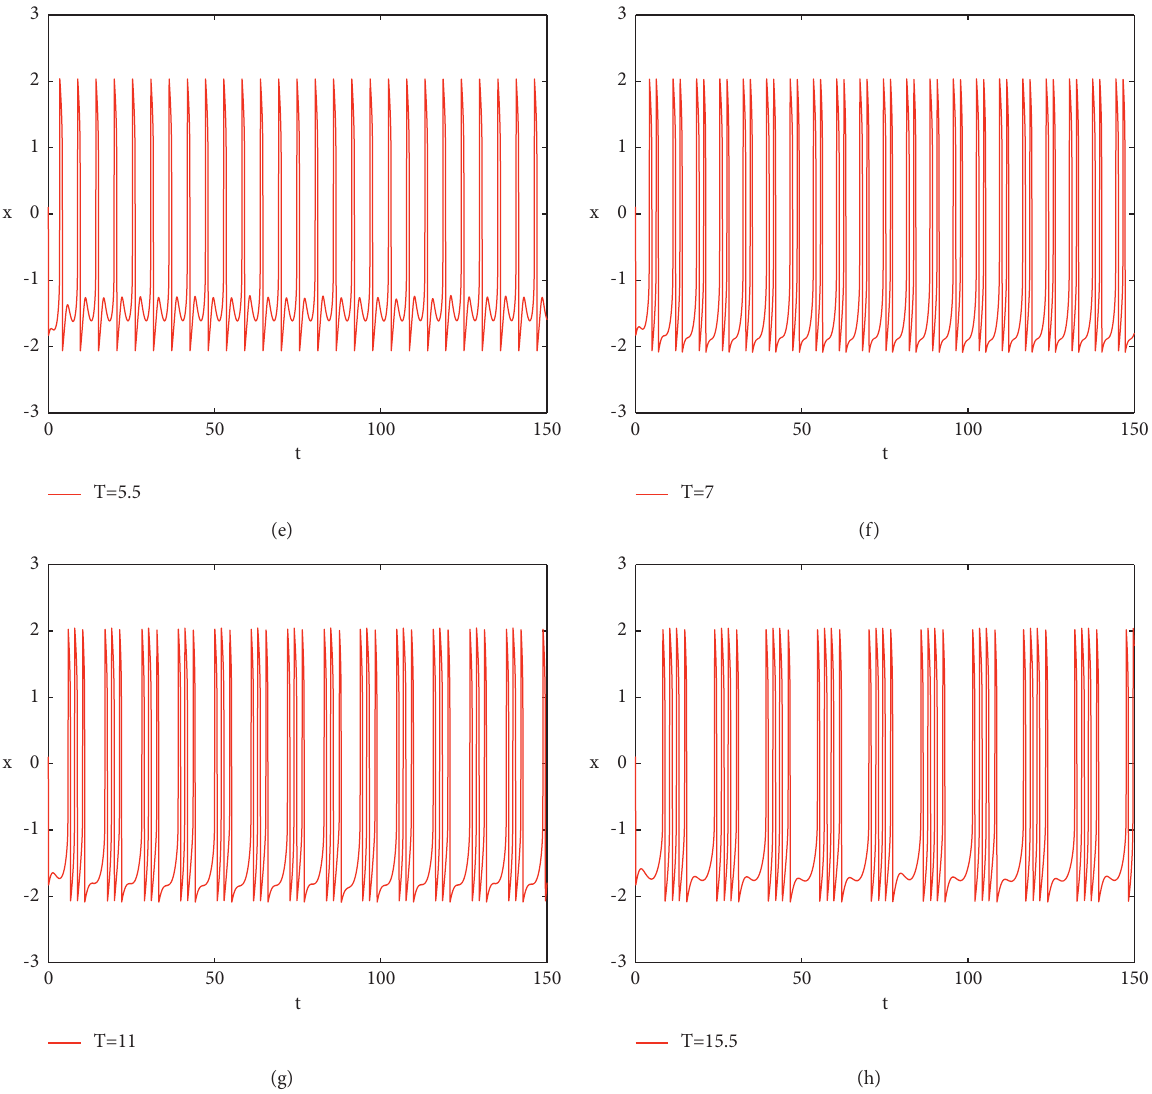
Figure 5: When phase noise amplitude B � 0 . 76, the plot of the coherence resonance coefficient R varying with phase noise period T and the time evolution diagram of the system membrane potential x . (a) Variation of R with T ; (b) T � 2; (c) T � 3; (d) T � 4; (e) T � 5 . 5; (f) T � 7; (g) T � 11; (h) T � 15 .